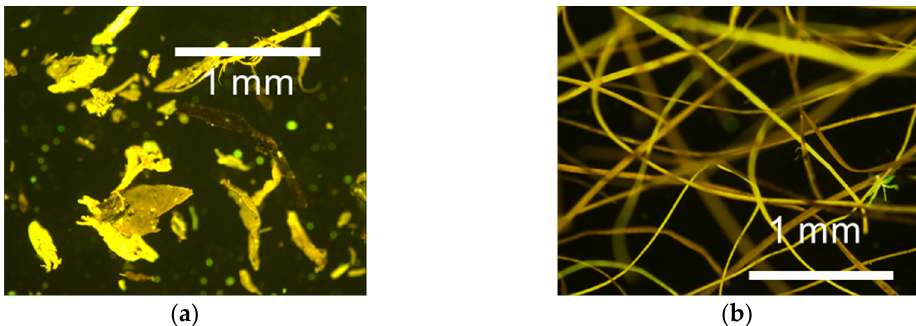
Figure 2. ( a ) The obtained peat powders and ( b ) the granulometric composition of the peat powders and filler.